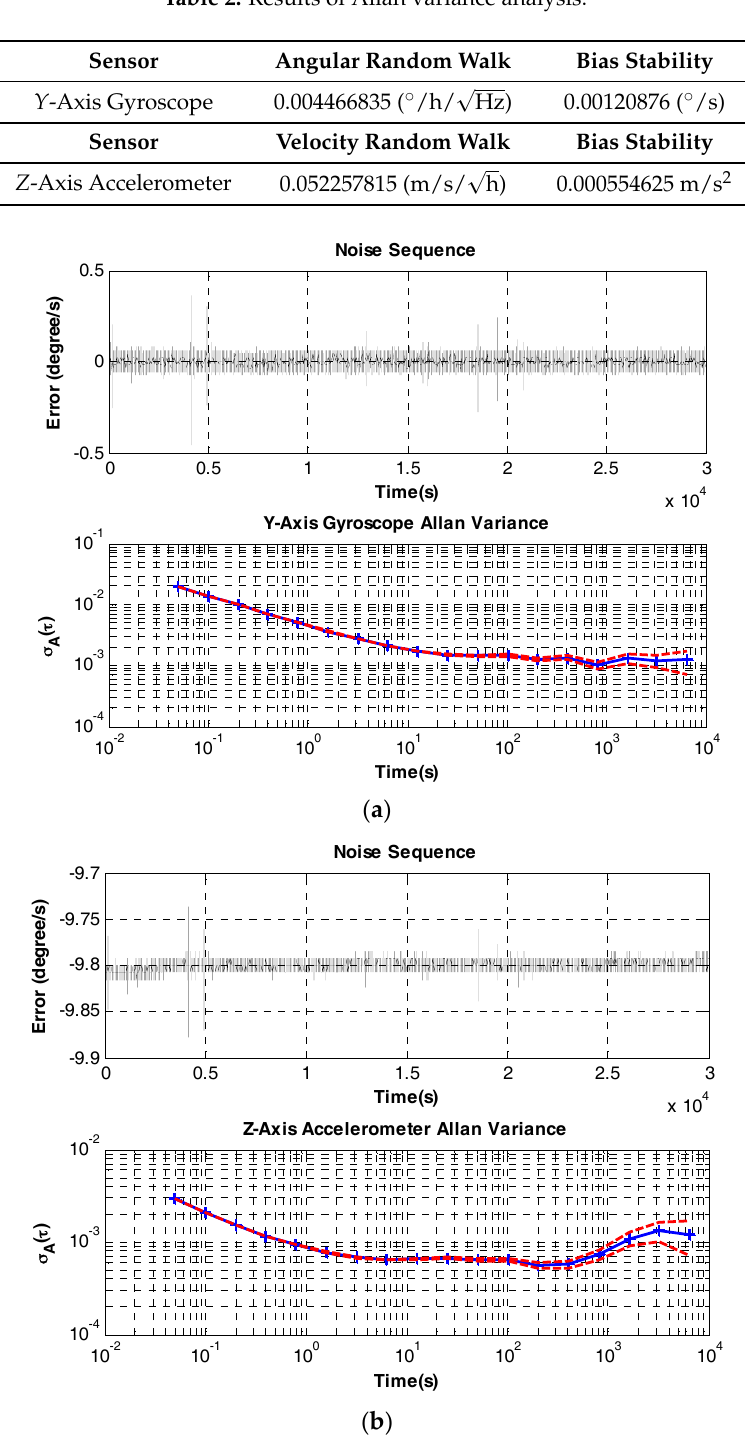
Figure 8. ( a ) Y -Axis Gyroscope Allan variance analysis; and ( b ) Z -Axis accelerometer Allan variance analysis.